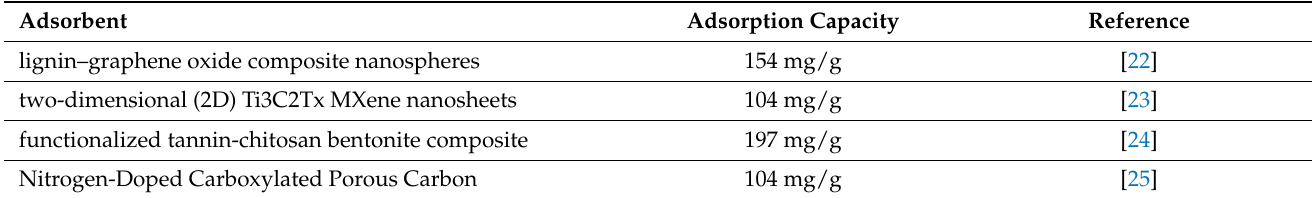
Table 4. Comparison of adsorption capacity with other adsorbents from previous